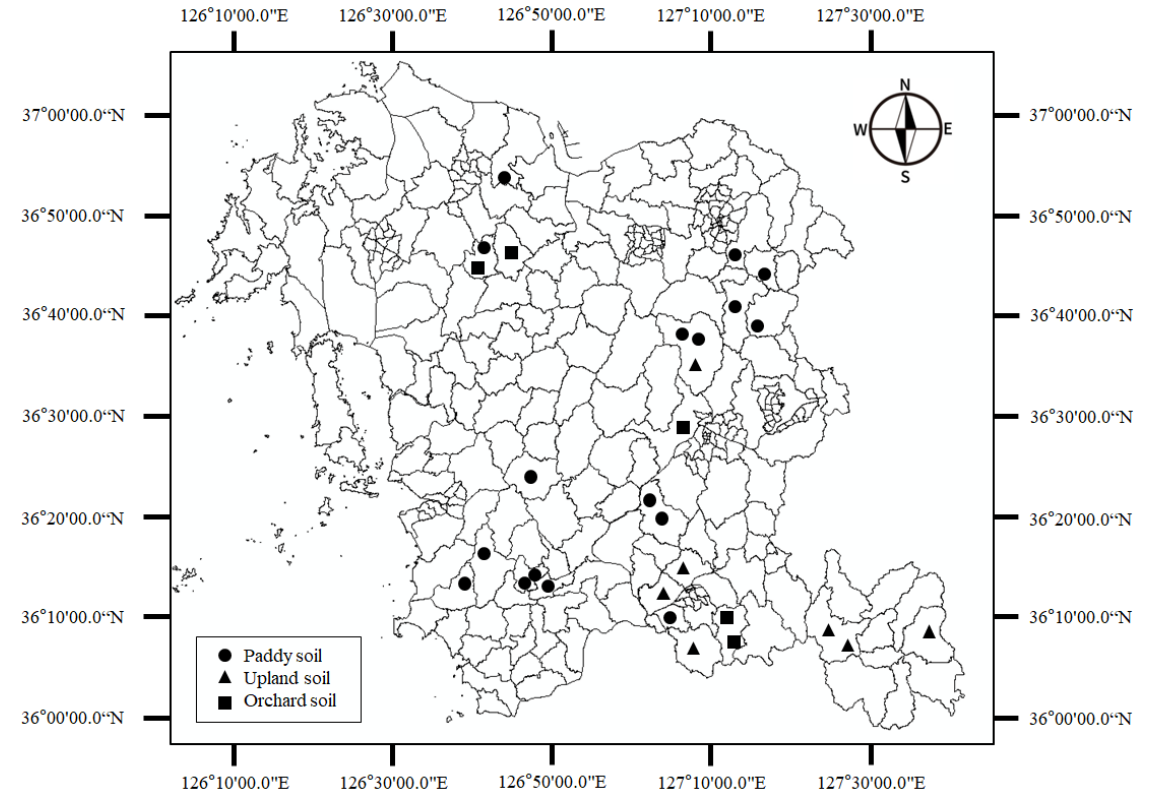
Figure 1. Overview of the study area, Chungcheongnam-do province of South Korea. Locations of the sampling sites are shown as black dots.